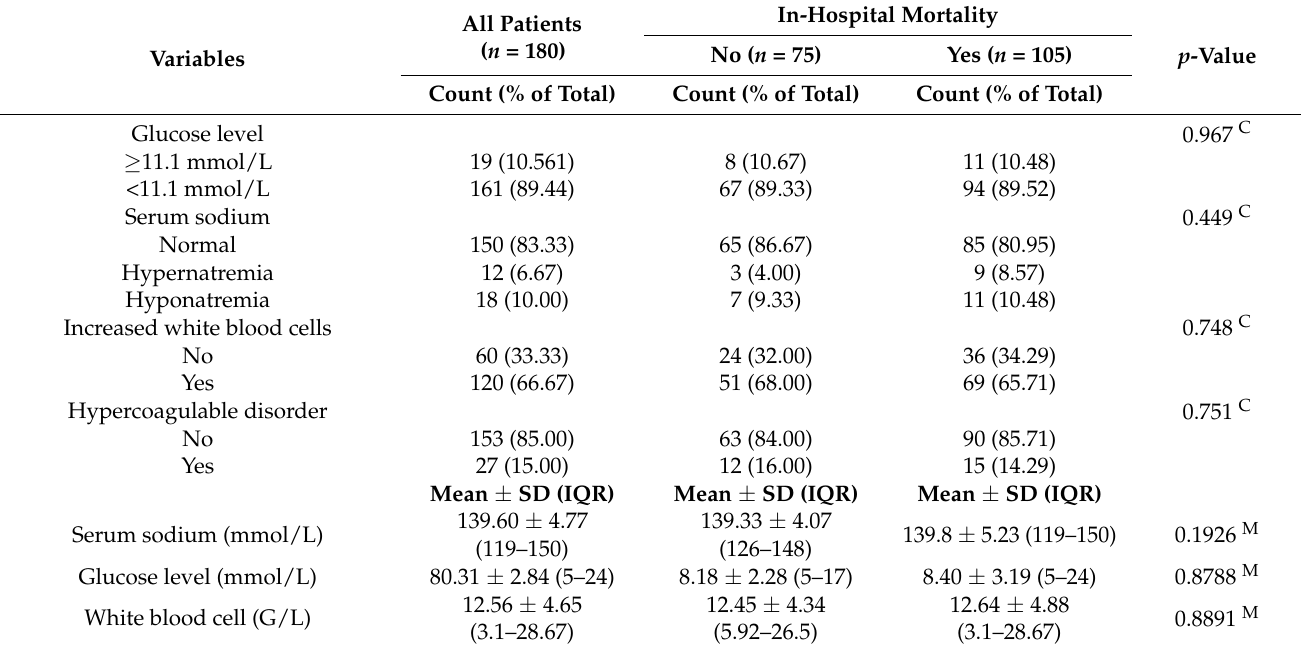
Table 2. Admission laboratory testing in the in-hospital survival and in-hospital mortality patients with ICH.